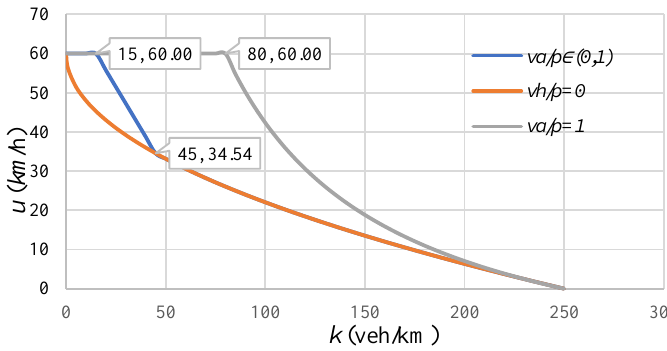
Figure 6. Speed fluctuation graph when p takes different values.